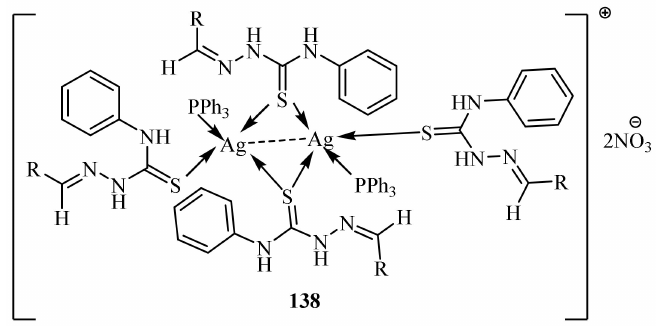
Figure 3. Structures of the silver complexes 138